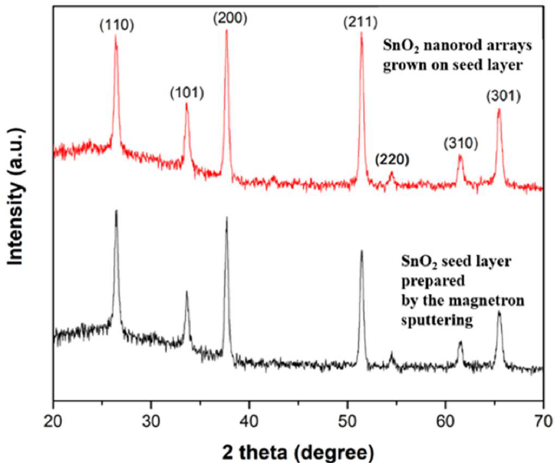
Figure 8. The XRD patterns of the SnO 2 seed layer prepared by the magnetron sputtering and solvothermally grown SnO 2 nanorod arrays.